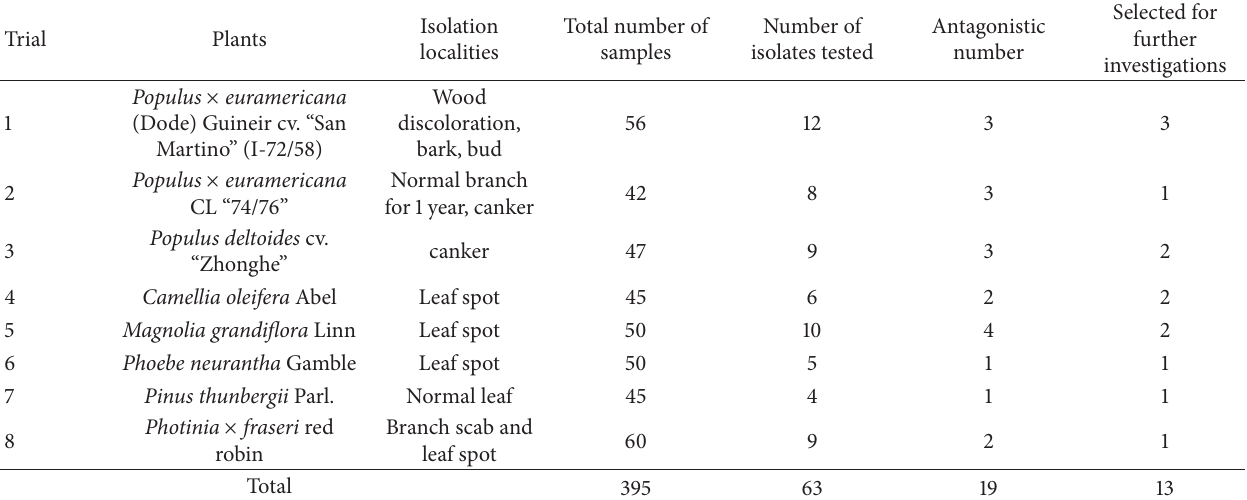
Table 1: The isolation of biocontrol bacteria from different